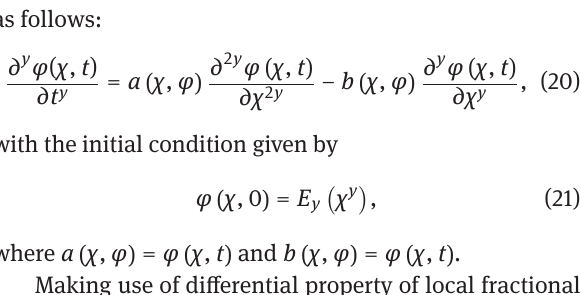
Fig. 4: Numerical simulation of the solution in closed form with non- differentiable term when γ = ln2